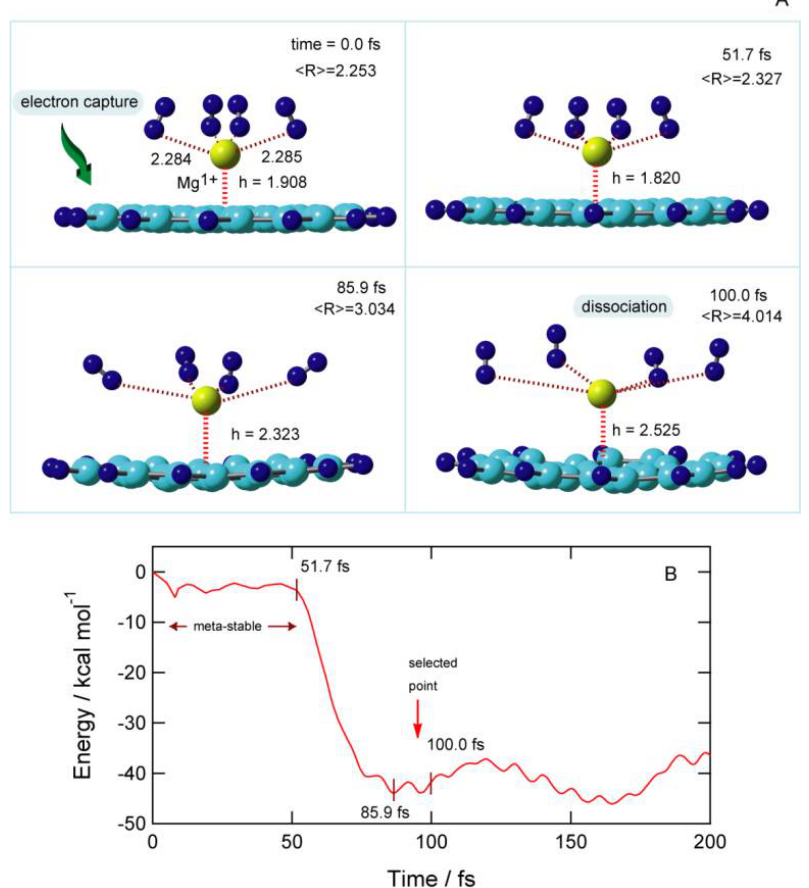
Figure 12. ( A ) Snapshots of GNF–Mg + –(H 2 ) 4 following the electron capture of GNF–Mg 2+ –(H 2 ) 4 . ( B ) ( B ) Time evolution of potential energy of GNF–Mg + -(H 2 ) 4 . Direct AIMD calculations were